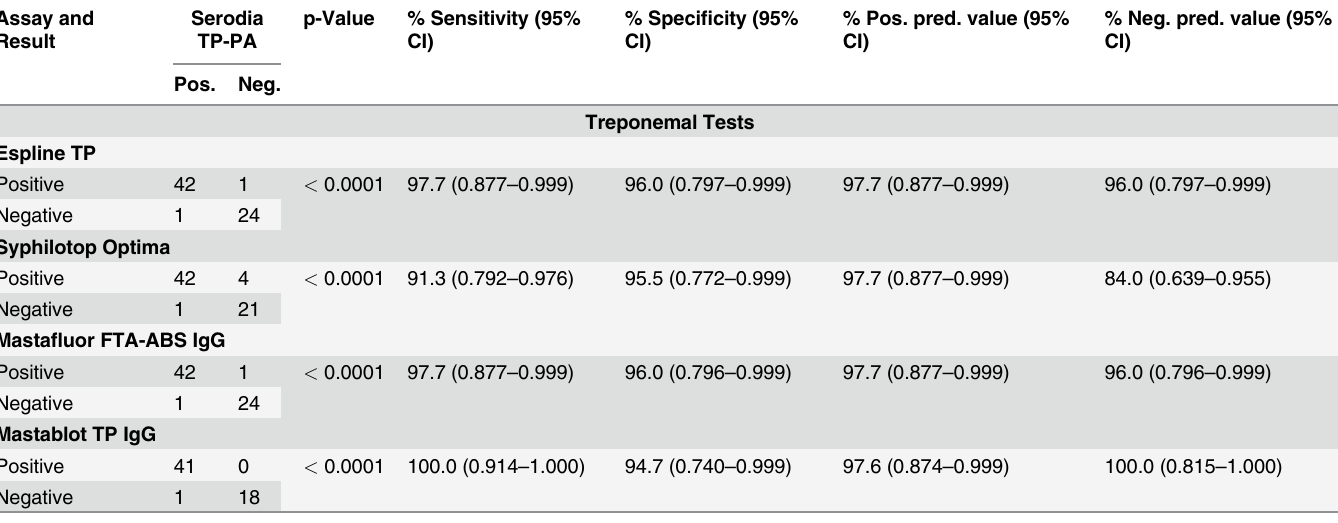
Table 3. Comparison of treponemal serological tests with the results of the Serodia TP-PA. Assay and Serodia Result